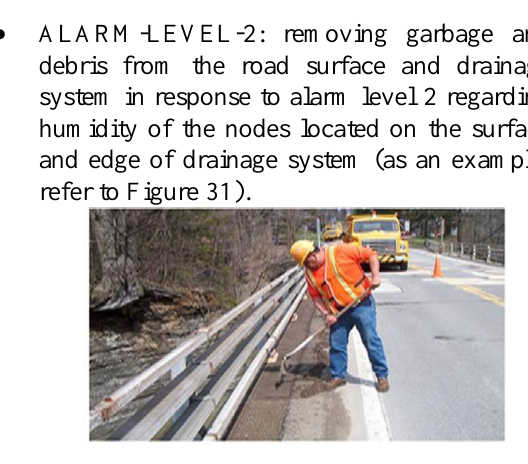
Figure 31. Removing garbage and debris from road surface and drainage system to address alarm [5].